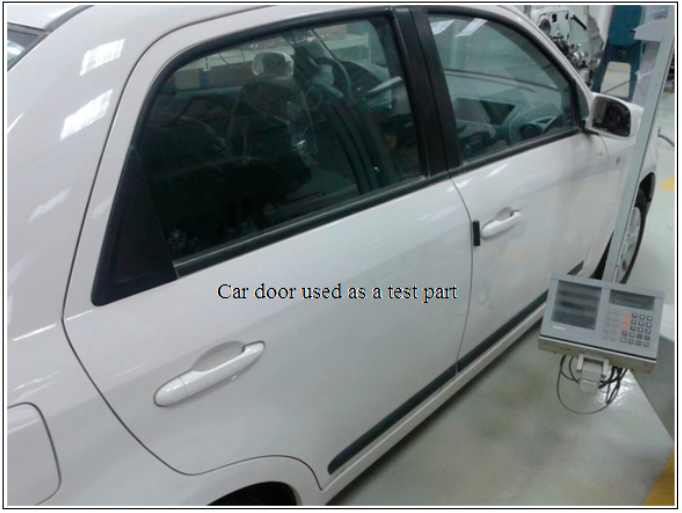
Figure 3. Test part selected for the comparative evaluation.